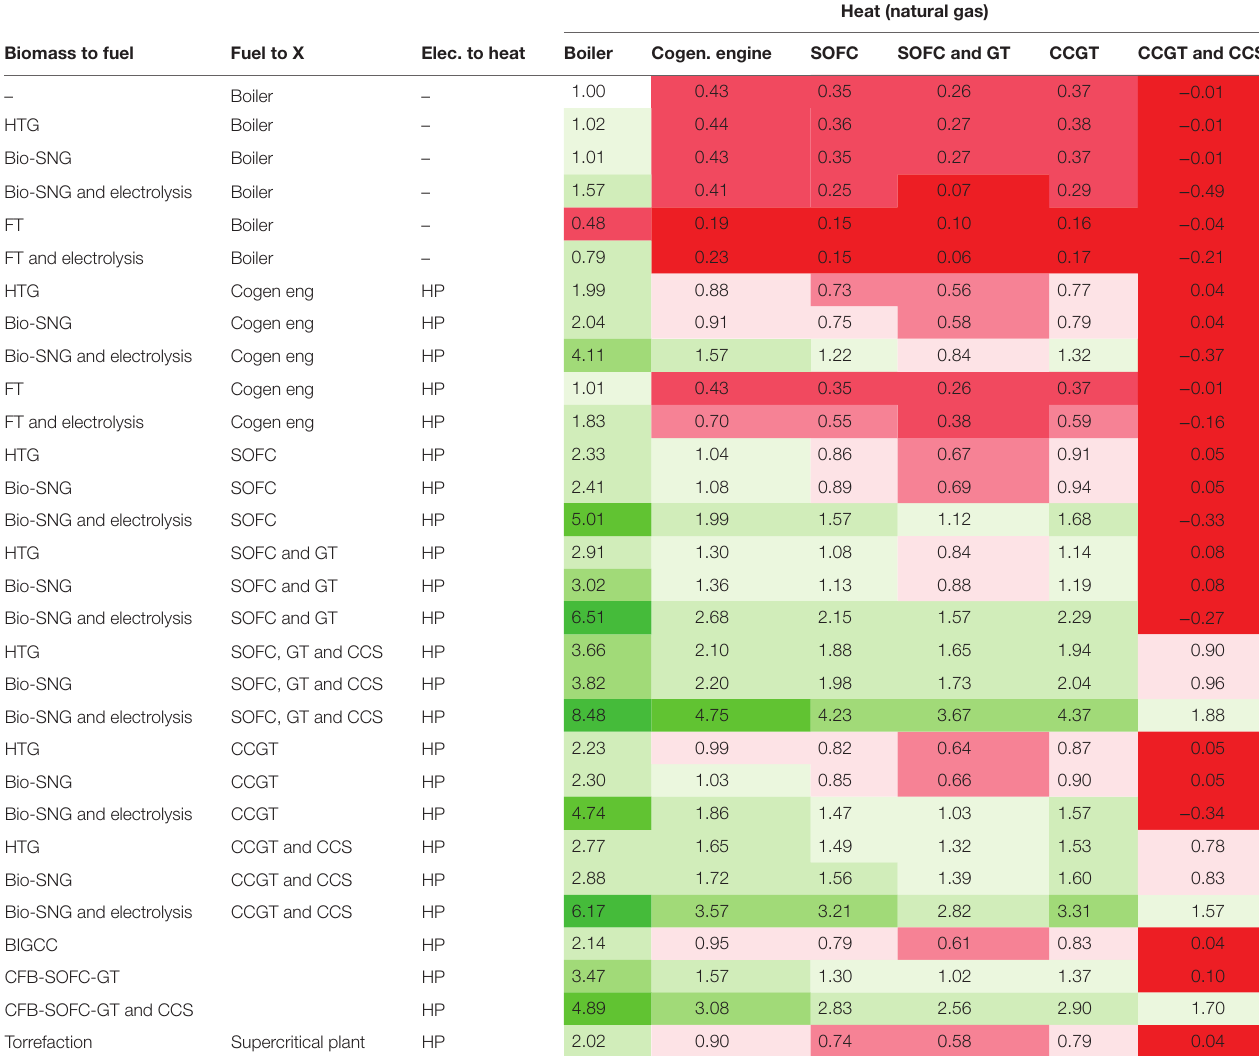
Table cells colored in shades of green correspond to solutions that have a better mitigation effect than the use of biomass in a boiler, while cells colored in shades of red represent solutions where the mitigation effect is lower.